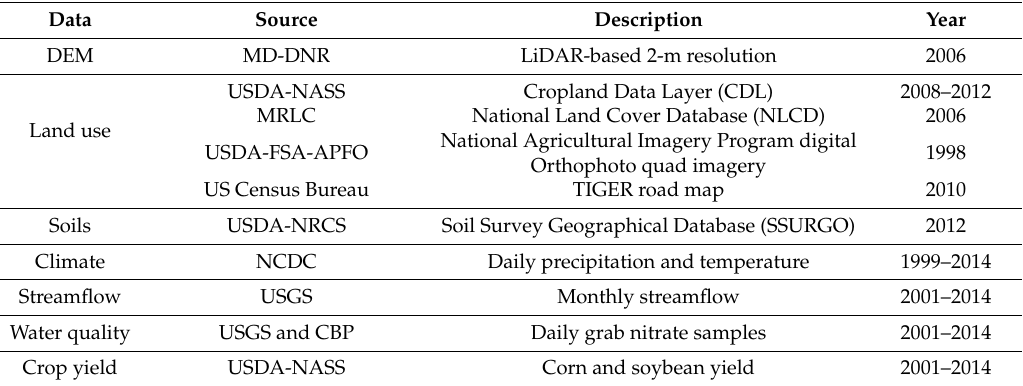
Table 1. The list of input data (adapted from